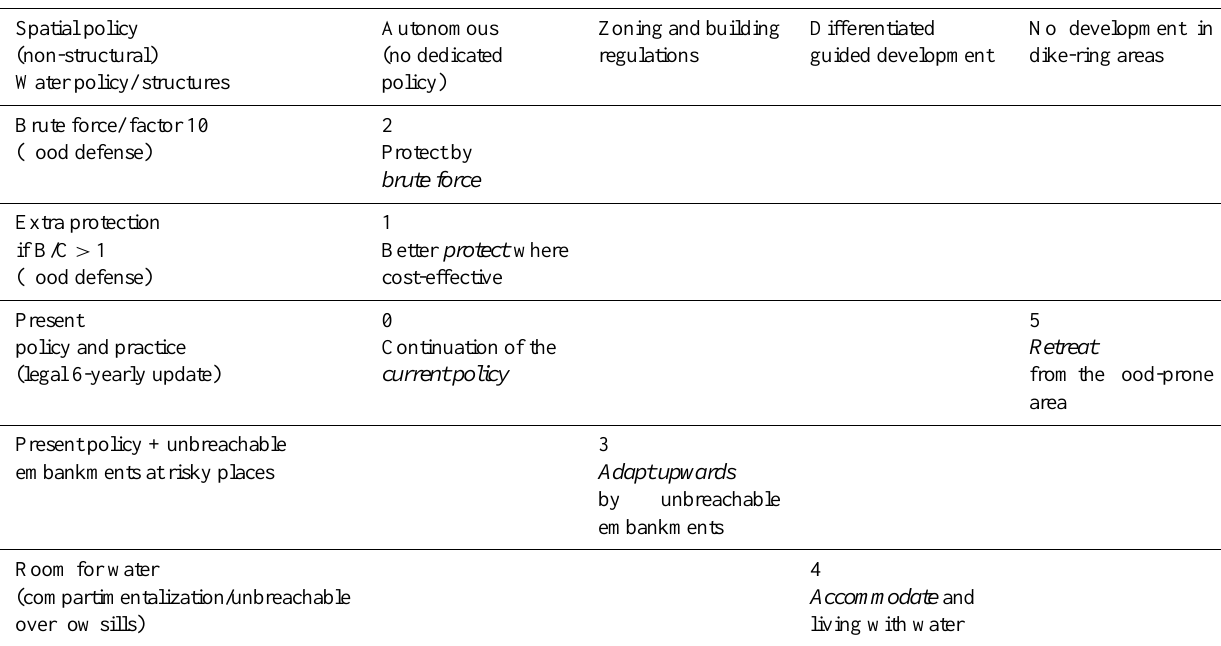
Table 2. The investigated strategic alternatives, as combinations of measures from water policy (flood defence, flood control; vertical axis) and from spatial policy (zoning, regulatory measures; horizontal